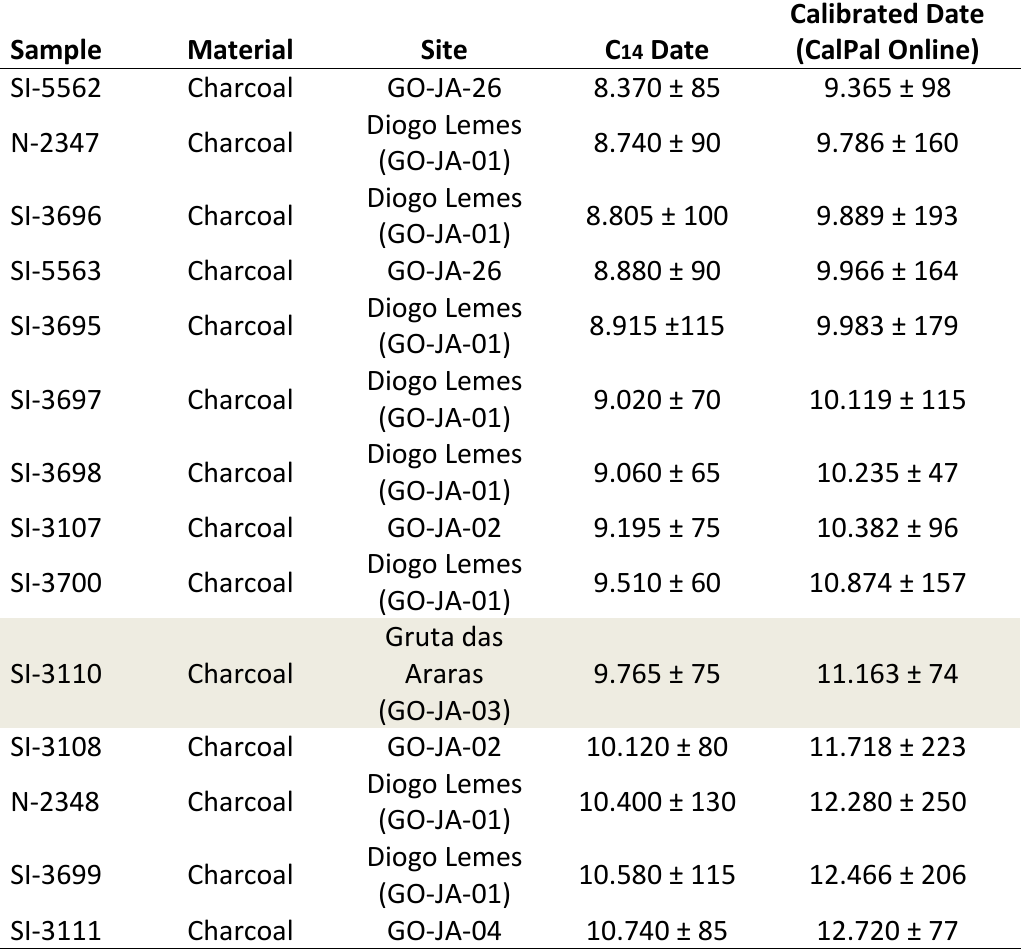
Table 2. Pleistocene-Holocene dates at Serranópolis archaeological complex. Bold date related to analyzed material in this